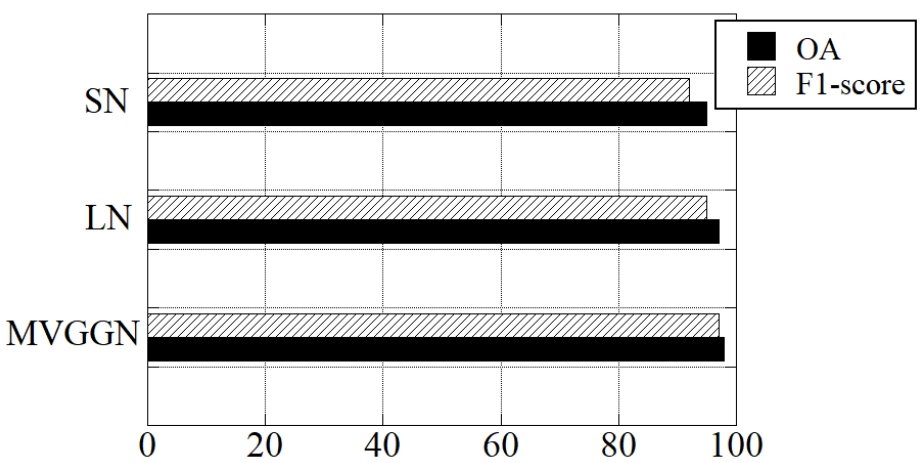
Figure 11. Comparison of ShallowNet (SN), LeNet (LN), and MiniVGGNet (MVGGN) models in overall accuracy and F1 score of wildfire results.